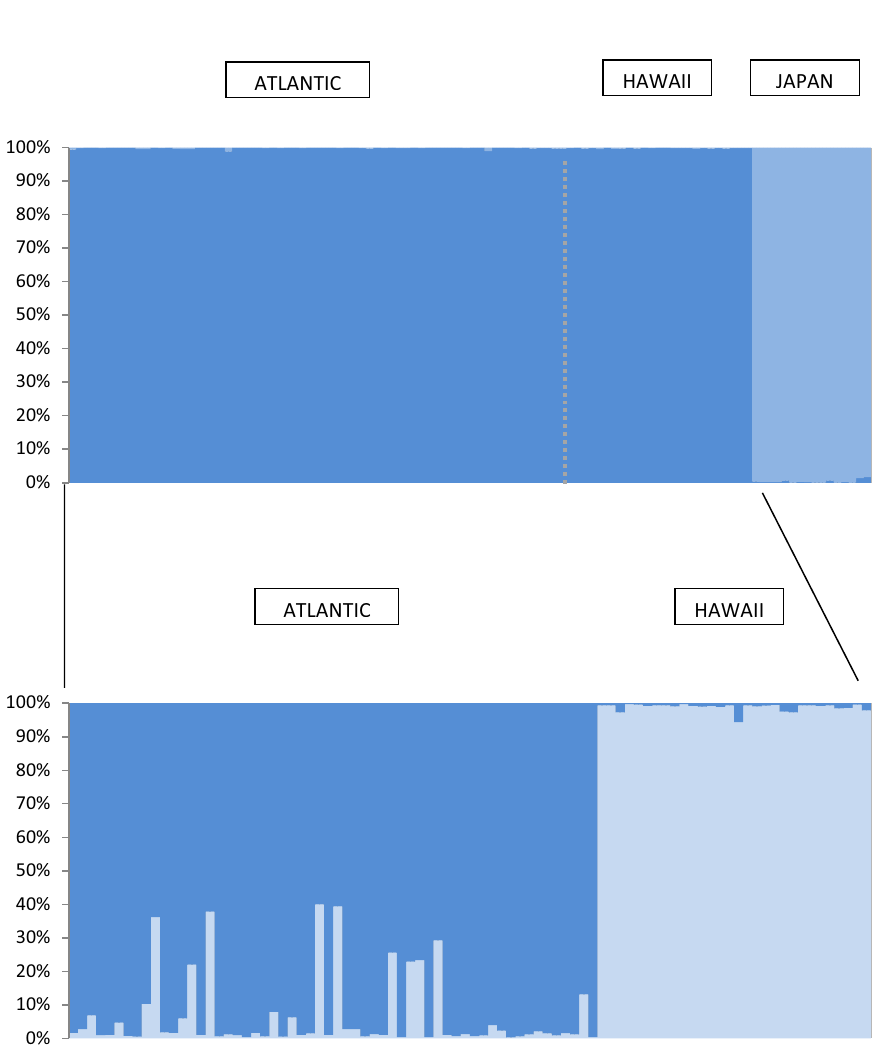
Figure 2. Structure results. Bayesian assignments of co-ancestry for all sampled Bulweria bulwerii individuals based on nuclear anonymous genotypes. For all samples, the inferred best K by the Evanno et al. 31 method was two clusters, in both